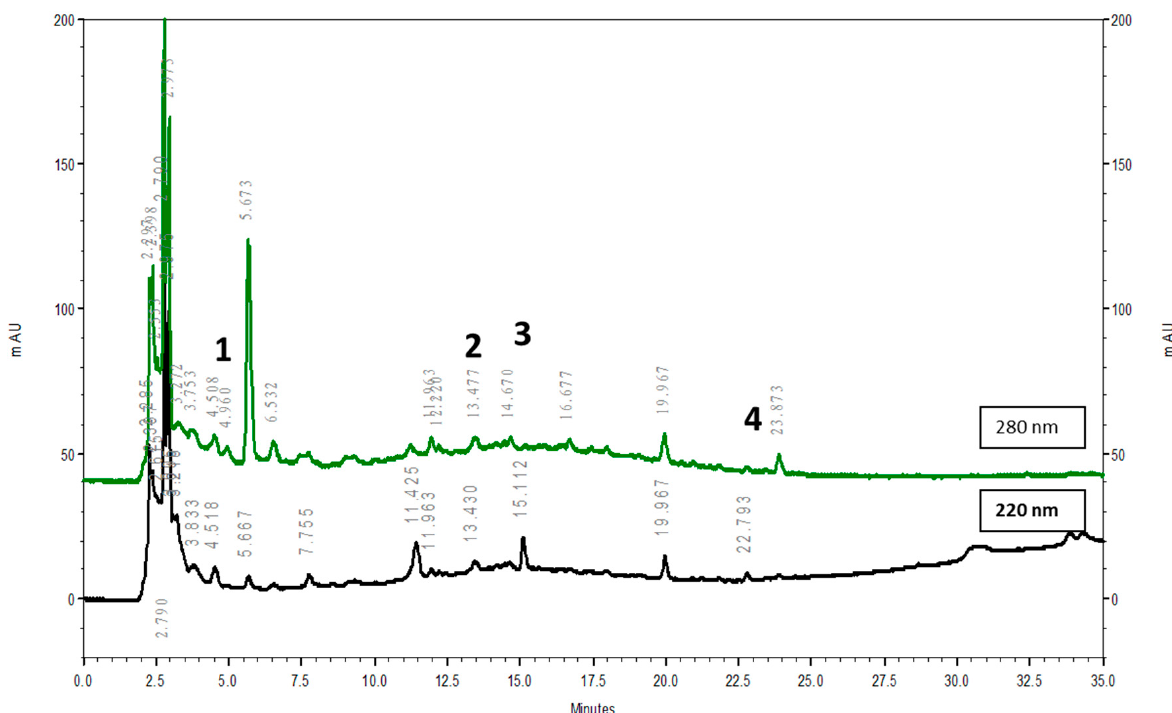
Figure 1. Chromatogram of high-performance liquid chromatography of You-Gui-Wan (YGW) decoction. HPLC was run on a Hitachi 5160; 5430 DAD with 5310 oven (40 °C); column: COSMOSIL 5C18-AR-II (250 × 4.6 mm); solvents: A, methanol; B, 0.1% H 3 PO 3 ; mobile phase: 0–5 min, 15–20% A; 5–20 min, 20–60% A; 20–30 min, 60–80% A; 30–35 min, 80% A; 35–37 min, 80–15% A; detector: UV: 220 & 280 nm; flow rate: 1 mL/min. 1: gallic acid; 2: caffeic acid; 3: loganin; 4: cinnamaldehyde.